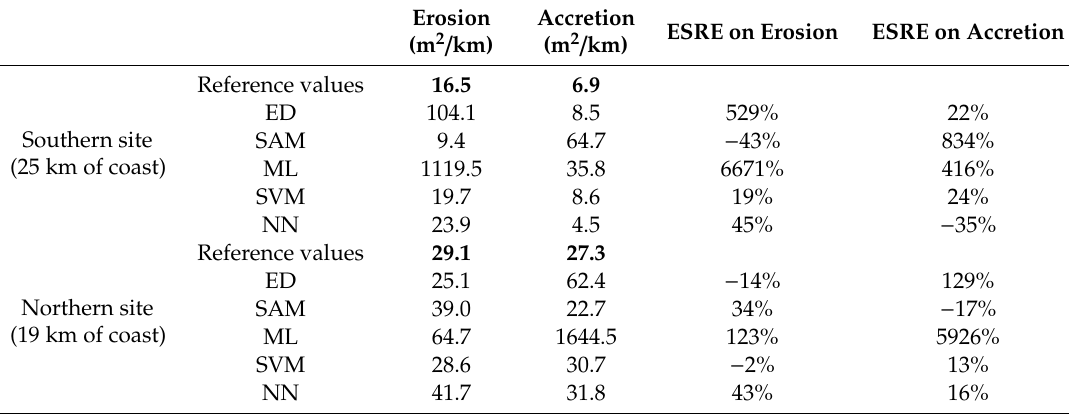
Table 3. Erosion and accretion pixels desired (the reference) and retrieved by the 5 methods for the two sites. The Estimated Surface Relative Error (ESRE) is also reported. Minimum values of ESRE on erosion and accretion for each site are displayed in